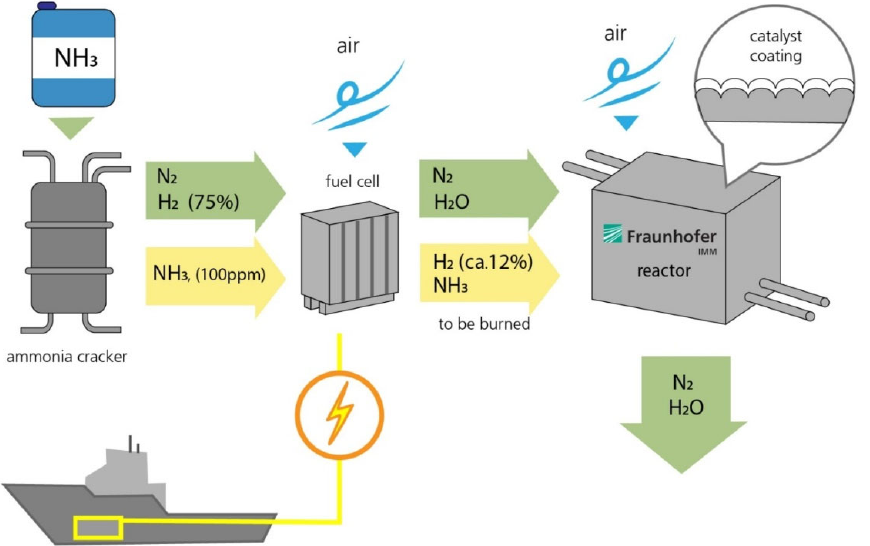
Figure 13. In the ammonia cracker, ammonia is separated into nitrogen and hydrogen. It is then later used to generate power in the fuel cell. No hazardous nitrogen oxides are created thanks to the catalytic converter. Water and nitrogen are the only end products [112].